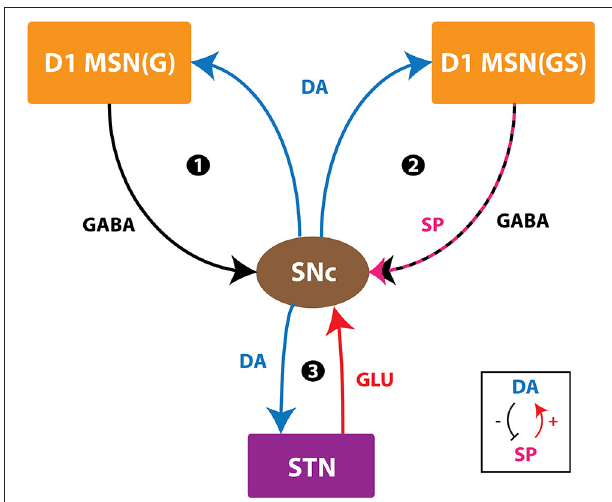
FIGURE 9 | Positive feedback loops of SNc. SNc, substantia nigra pars compacta; STN, subthalamic nucleus; D1 MSN(G), D1-type DA receptor-expressing medium spiny neuron (release GABA); D1 MSN(GS), D1-type DA receptor-expressing medium spiny neuron (co-release GABA and SP); DA, dopamine; SP, substance P; GLU, glutamate; GABA, gamma-aminobutyric acid. Inset, DA-SP